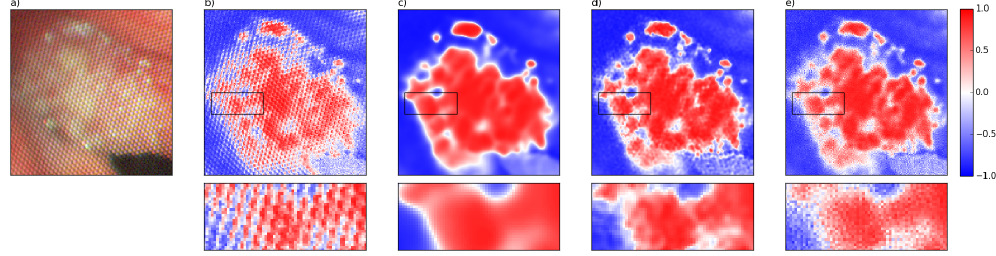
Figure 10. Results of cancerous tissue detection by hyperspectral classification using correlation for the zoomed area which shows the cancerous tissue of #caseA ( a ). As underlying data for classification, we used ( b ) raw data; ( c ) SD Gaussian filtered data; ( d ) star-shaped filtered data; and ( e ) data filtered by our